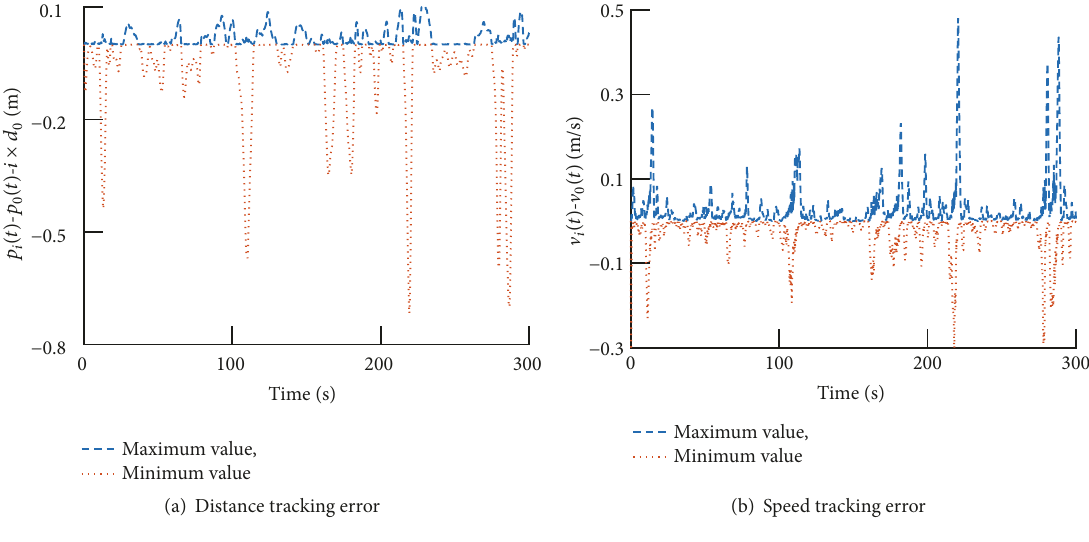
Figure 10: Maximum and minimum tracking errors under the disturbed condition.